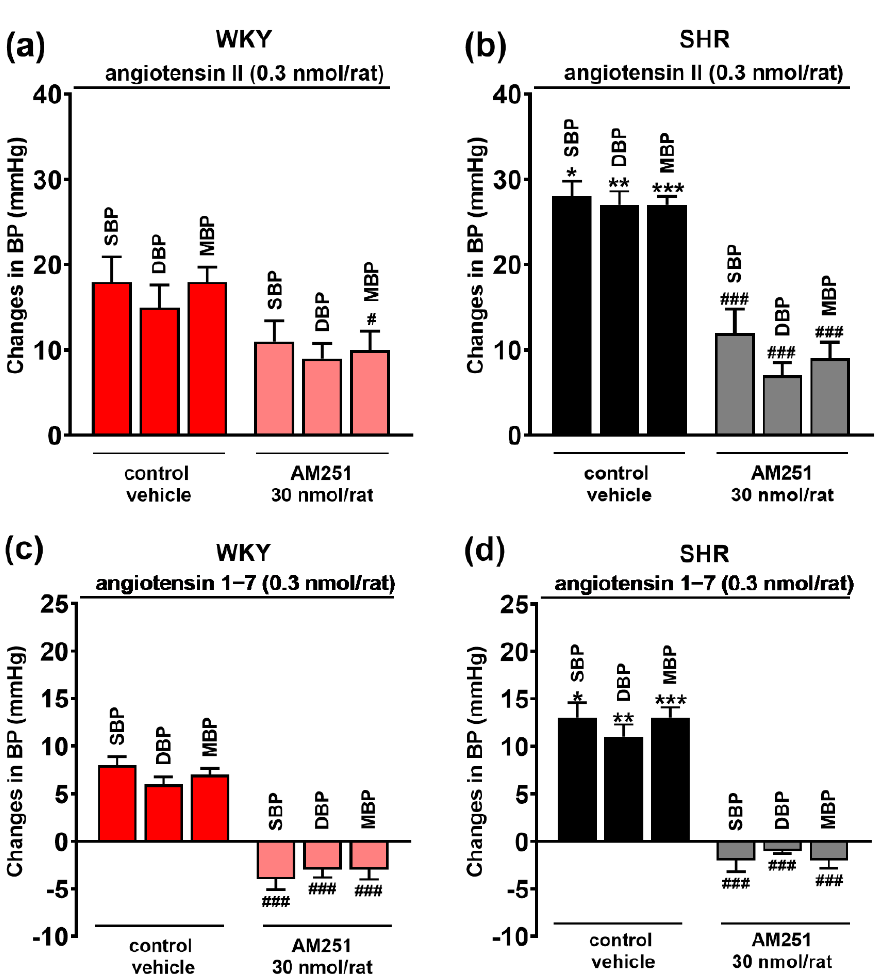
Figure 5. Influence of the CB 1 receptor antagonist AM251 on the pressor effect of angiotensin II (AT 1/2 receptor agonist) ( a , b ) and angiotensin 1–7 (Mas receptor agonist) ( c , d ) injected into the paraventricular nucleus of hypothalamus (PVN) in conscious Wistar Kyoto (WKY) and spontaneously hypertensive rats (SHR). Results, presented as mean ± SEM ( n = 7–8), are calculated as change in basal values determined before agonist/antagonist injection. # p < 0.05, ### p < 0.001 compared to the corresponding control group. * p < 0.05, ** p < 0.01, *** p < 0.001 compared to WKY.